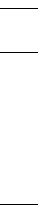
Table 1. Sediment shortwave insolation fractions for lakes with di- mensionless shortwave extinction β = 27 and various shape fac- tors s .